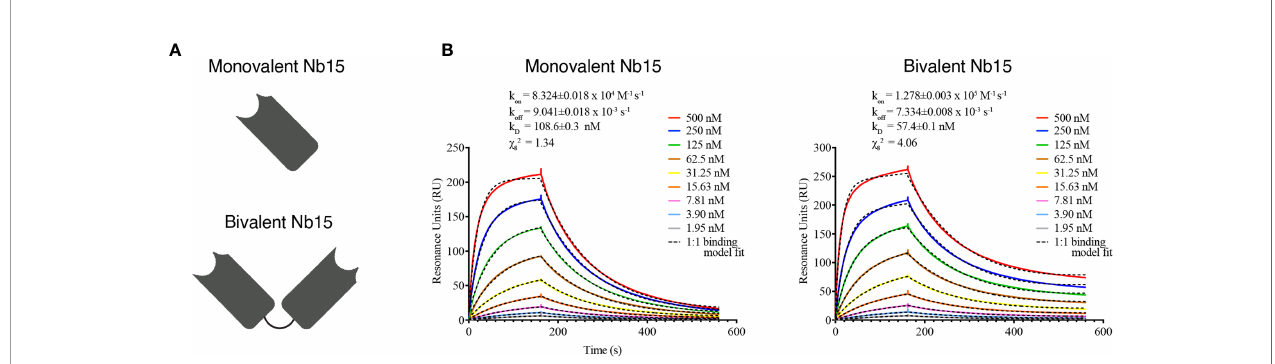
FIGURE 5 | Bivalent anti-SIRP a Nb15 binds SIRP a . (A) Schematic representation of mono- and bivalent anti-SIRP a Nb15. (B) Kinetic rate constants determination by SPR: the sensorgrams of different concentrations (2x serial dilution) of mono- and bivalent anti-SIRP a Nb15 binding to the recombinant antigen. Fitting of the binding curves was obtained by using a 1:1 mathematical model, for the mono- and bivalent constructs. Kinetic parameters are included as mean±SD.